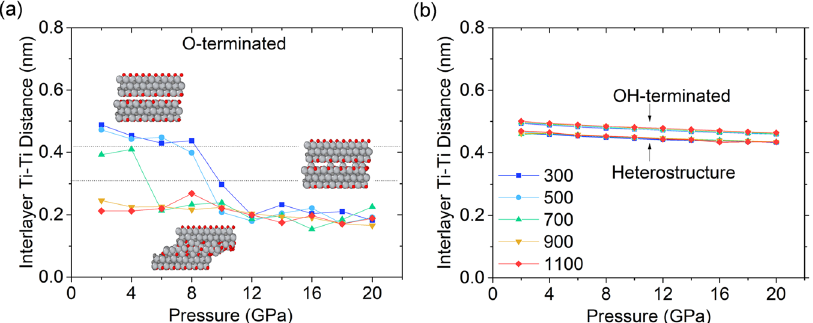
Fig. 3 Interlayer Ti – Ti distances. Interlayer Ti – Ti distance for a O-terminated MXenes, b OH-terminated and heterostructure MXenes as a function of pressure at 300, 500, 700, 900, and 1100 K. The insets in a are representative snapshots of the O-terminated model, from top to bottom, when there is no failure, as bonds start to form between the layers, and after